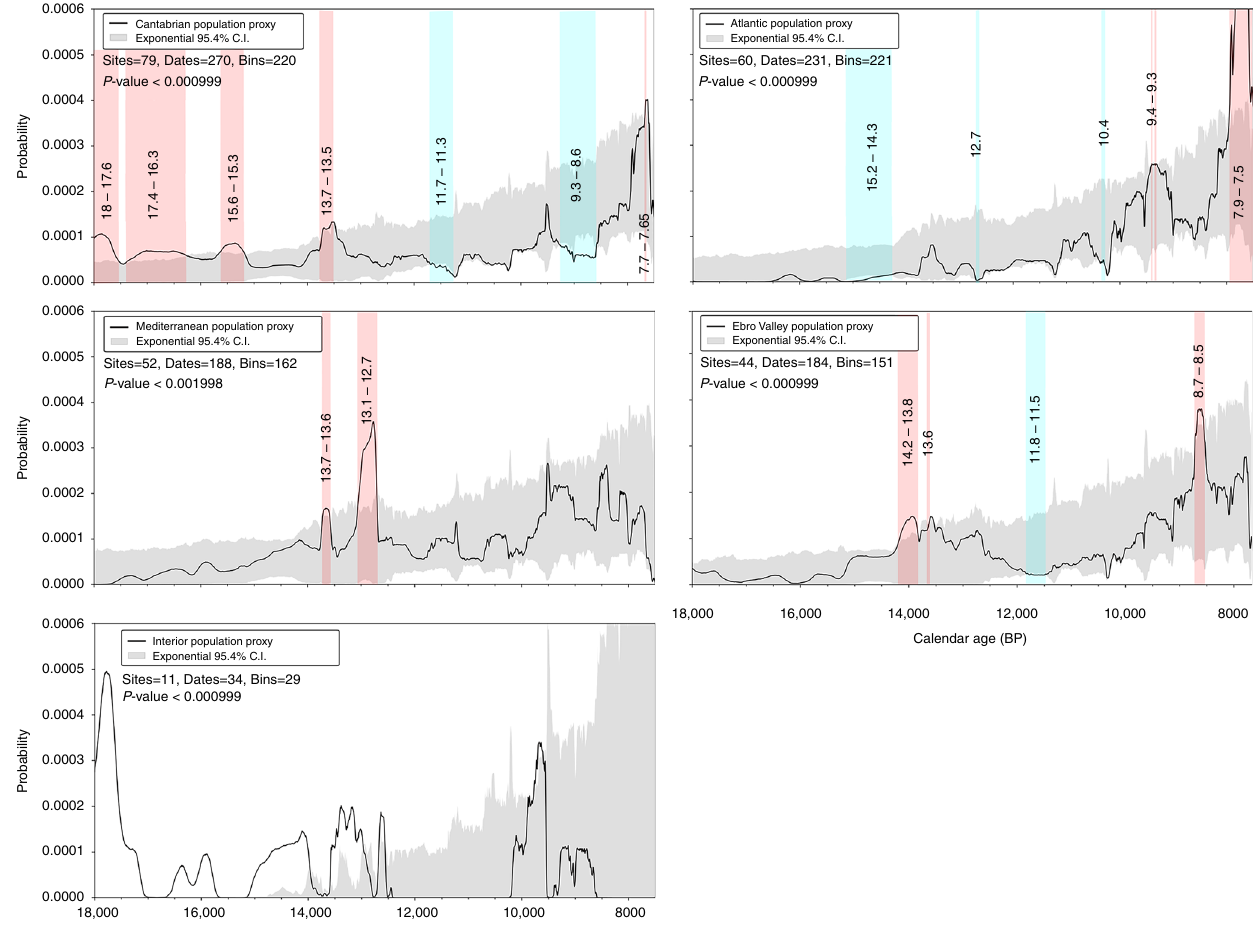
Fig. 3 SPD inferred population density changes between 18,000 and 7500 cal BP for each regional subset. The black bold line represents the population proxy based on the median of the taphonomically corrected SPD after applying bootstrap resampling. For each regional subset is compared with a null model of exponential demographic growth (in gray). The vertical pink and blue bands represent periods of signi fi cantly higher and lower population densities respectively compared to the null exponential model. The global p values are calculated using the computational method of Timpson et al. 8 for a set of simulated SPDs and express the global signi fi cance of the curve's departure from the null